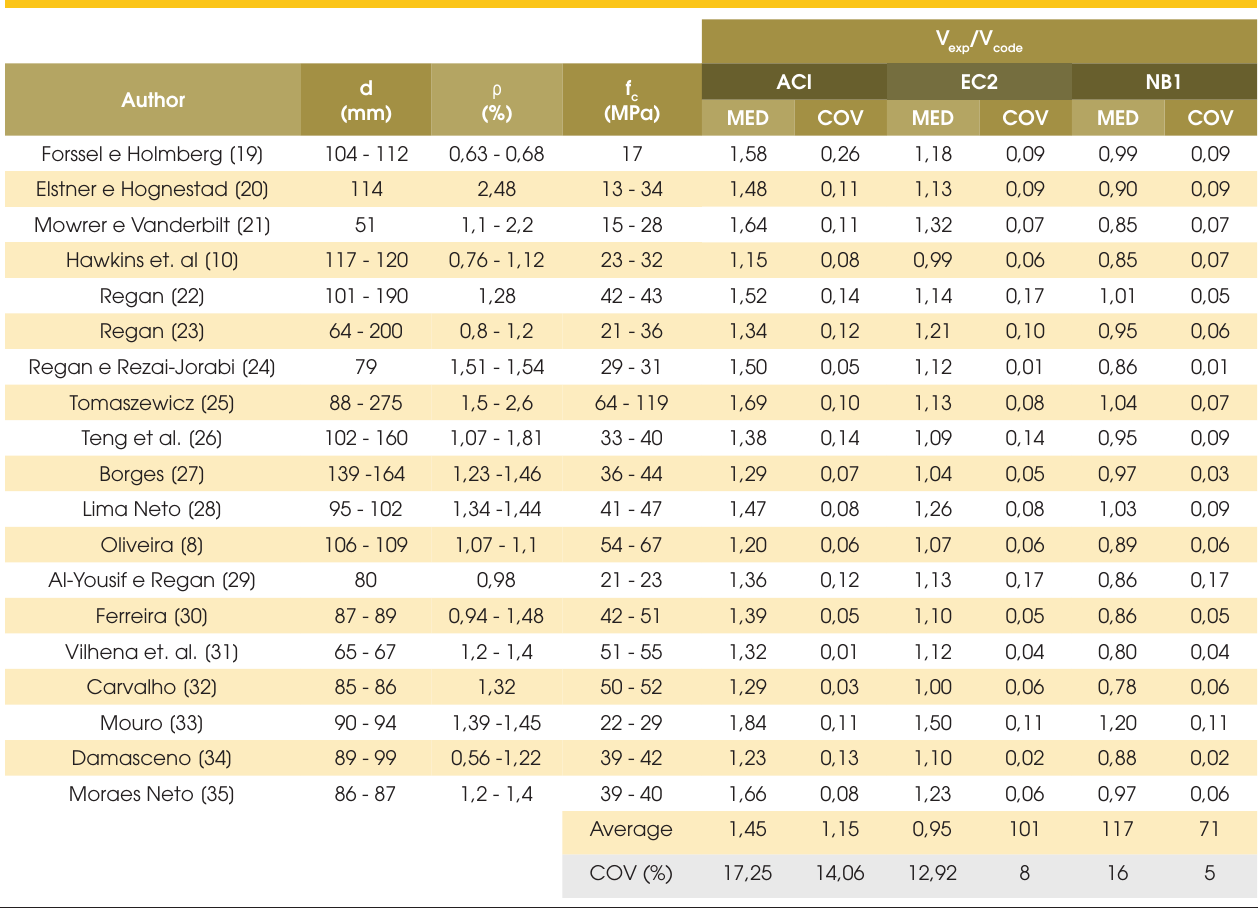
Table 3a – Comparison between the experimental and theoretical